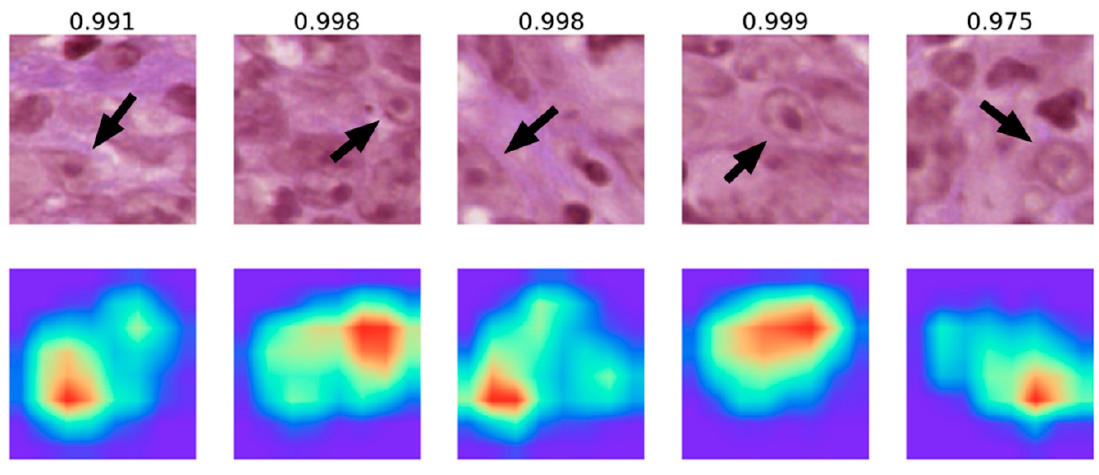
Figure 3. Results of gradient-weighted class activation mapping (Grad-CAM) on patches (256 × 256 pixels) classified as nasopharyngeal carcinoma (NPC) by our patch-level model. The lower row is the result of Grad-CAM, and the upper row is the corresponding hematoxylin and eosin (H&E) images for comparison. The numbers above each H&E image represent the probability of NPC produced by our patch-level algorithm. Note that the most important region (red color) for classifying a patch as NPC correlated with the location of a clearly identifiable cancer cell (arrows).